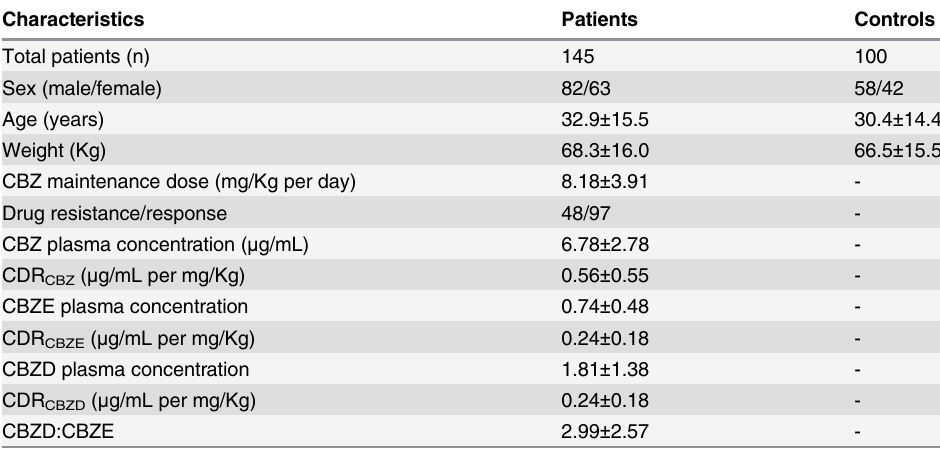
Table 1. Patient characteristics and dose-adjusted concentrations and reciprocal ratios of CBZ and its major metabolites CBZE and CBZD. CBZE: carbamazepine-10,11-epoxide; CBZD: 10,11-dihydroxy-